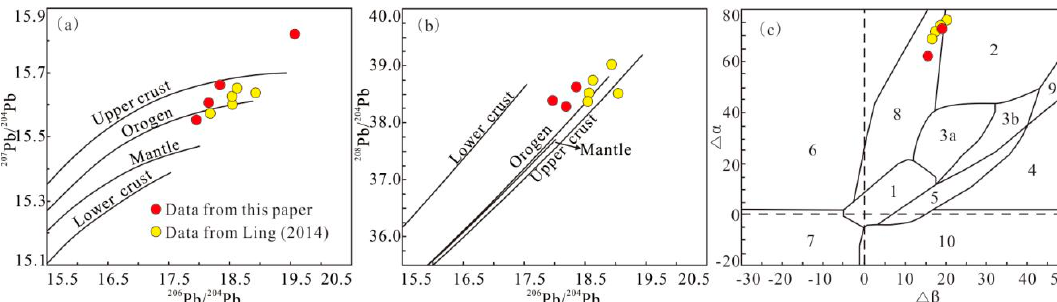
Figure 10. Diagrams of lead isotope of sulfides showing a mixing lead with majority coming from the orogen in the Niubiziliang Ni-(Cu) deposit (modified after Zartman and Doe (1981) [33]). 1, mantle; 2, upper crust; 3, magmatism in subduction zone; 3b, sedimentation in subduction zone; 4, chemically deposition; 5, submarine hot-water; 6, mesometamorphism; 7, hypometamorphism in lower crust; 8, orogen; 9, ancient shale in upper crust; 10, retrometamorphism. ( a ) Coming from the orogen and upper crust; ( b ) Coming from the orogen; ( c ) Coming from the orogen.